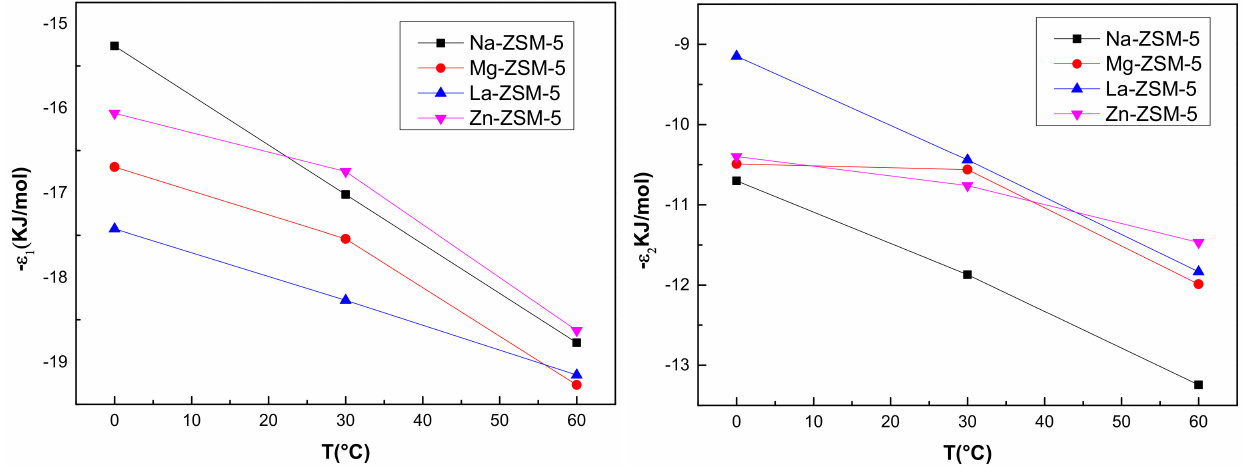
Figure 9. Effect of temperature on the CO 2 adsorption energy ( − ε 1 and – ε 2 ) of the Na-ZSM-5, Mg-ZSM-5, La-ZSM-5 and Zn-ZSM-5